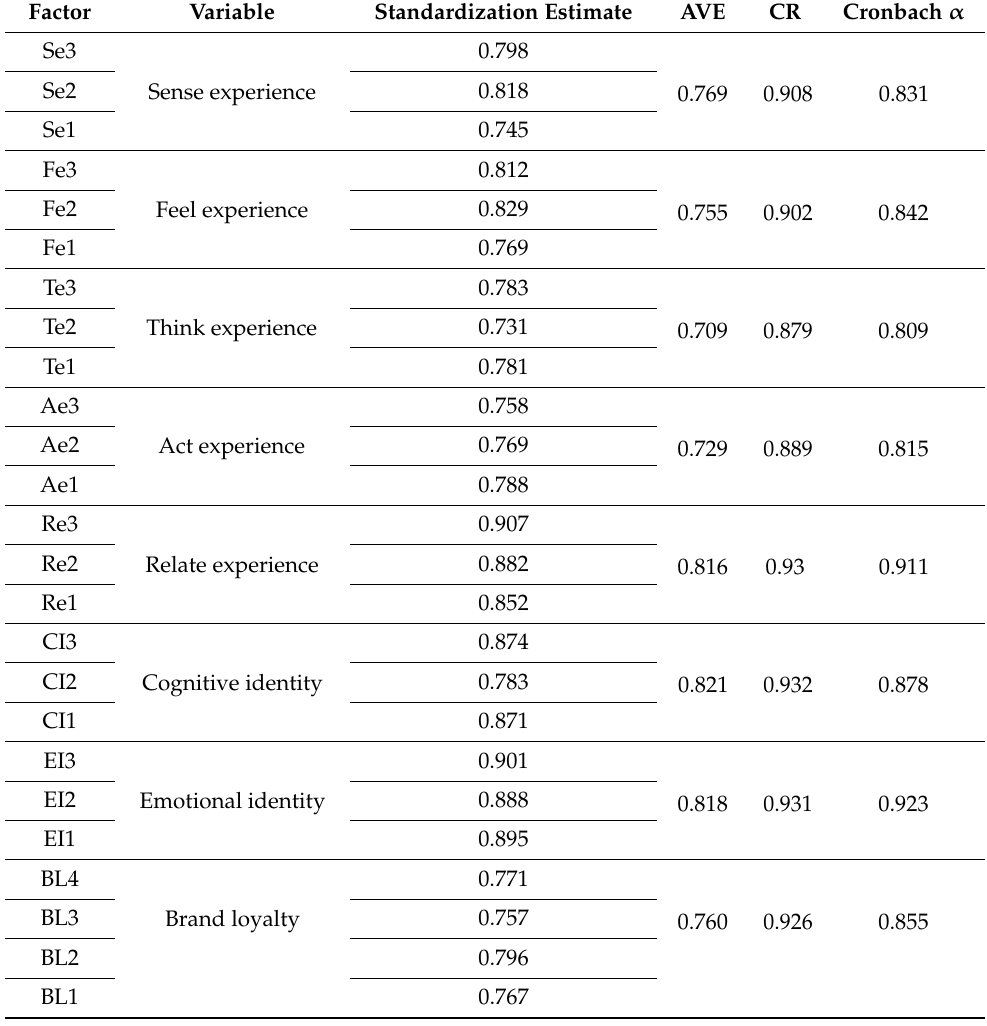
Table 2. Reliability Analysis.